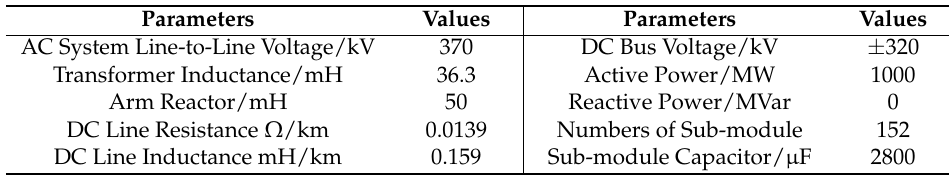
Table A2. Parameters of MMC-HVDC system